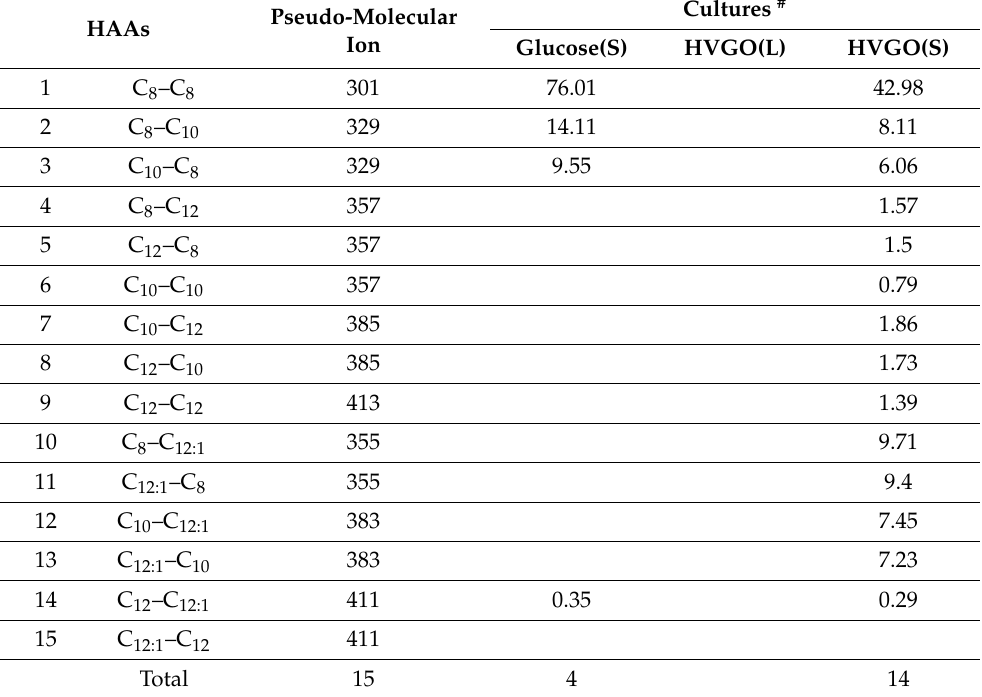
Table 1. Relative abundance (%) of HAAs produced in glucose and HVGO cultures of the AK6U strain.